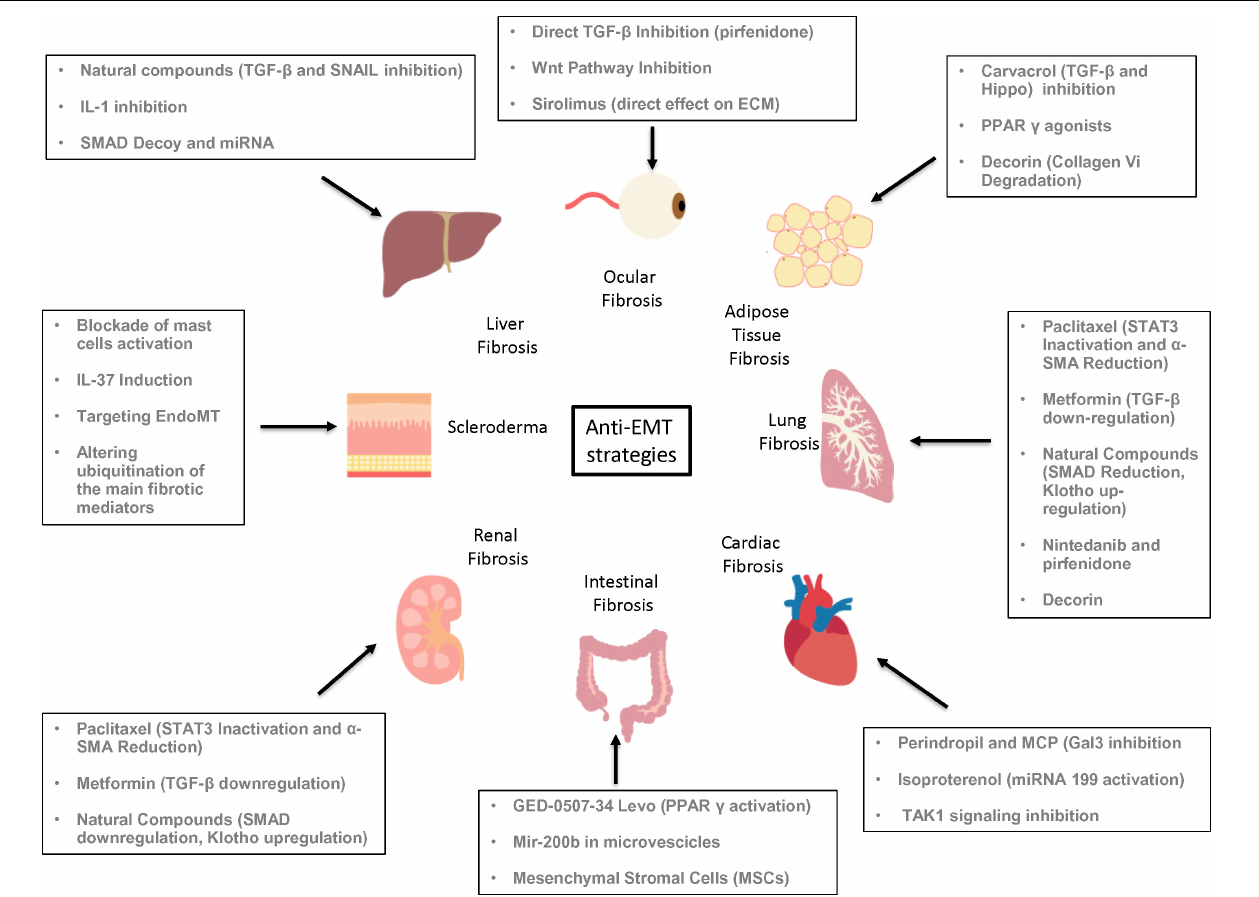
FIGURE 12 | Summary of the possible anti-EMT therapeutic strategies. For each organ fibrosis are highlighted some of the most promising experimental drugs and therapeutic approaches that may block or revert the EMT process, thus controlling the fibrotic